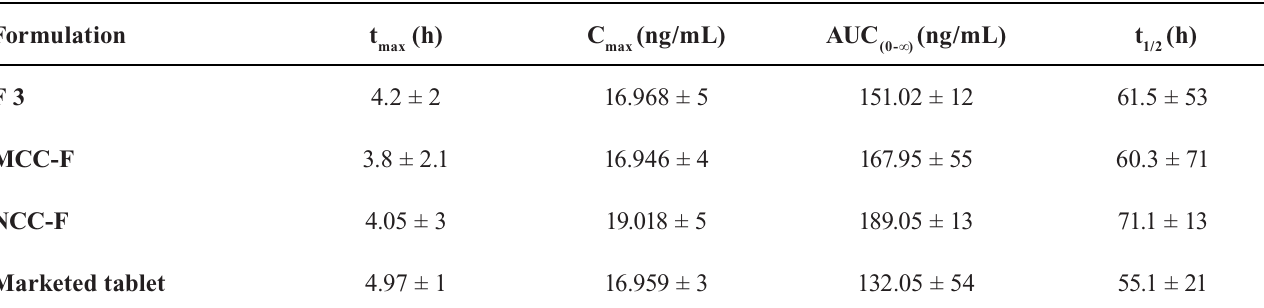
TABLE VI - Plasma concentration ( in vivo ) and pharmacokinetic parameters of final optimized ODF formulations. Oral administered (5 mg/kg) of drug Formulation